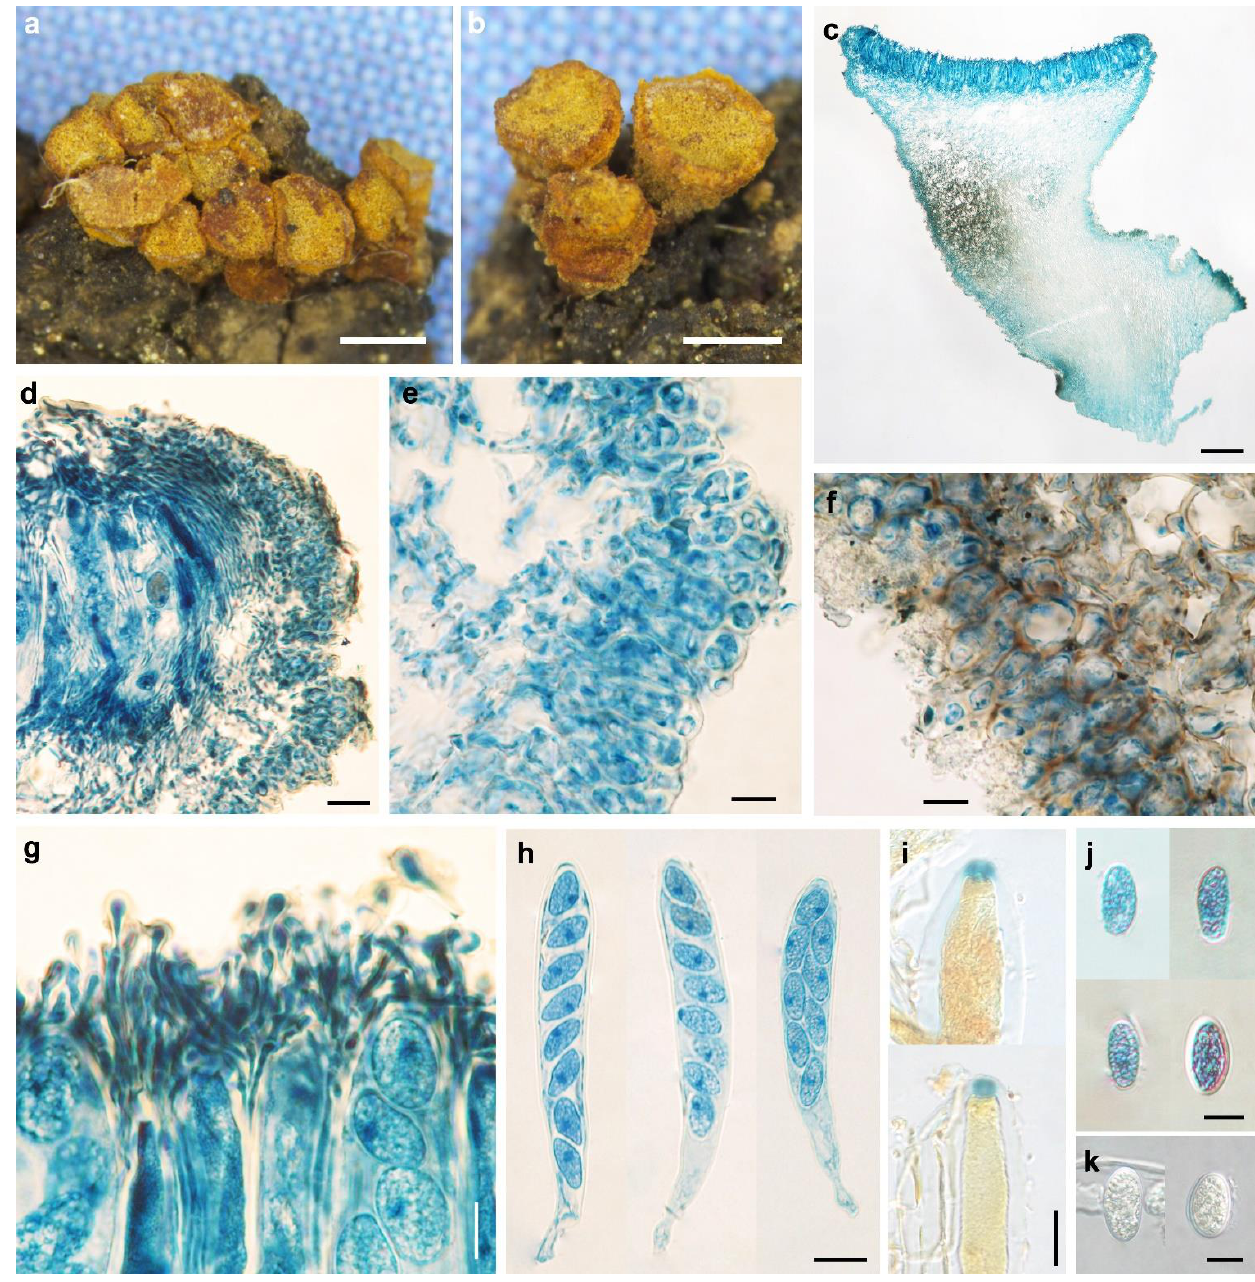
Figure 5. Pezicula carpinea (Pers.) Tul. ex Fuckel (HKAS 5295). ( a , b ) Dry apothecia on natural substrate; ( c ) longitudinal section of apothecium; ( d ) excipular structure of margin; ( e ) excipular structure of flank; ( f ) excipular structure adjacent to flank and stipe; ( g ) apices of asci and paraphyses; ( h ) asci; ( i ) IKI reaction of apical ring; ( j , k ) ascospores. Scale bars: ( a , b ) = 1 mm; ( c ) = 200 μm; ( d , h ) = 20 μm; ( e – g , i – k ) = 10 μm. Mounting media: ( c – h , j ) lactophenol cotton blue; ( i ) Lugol’s solution; ( k ) 3% KOH.